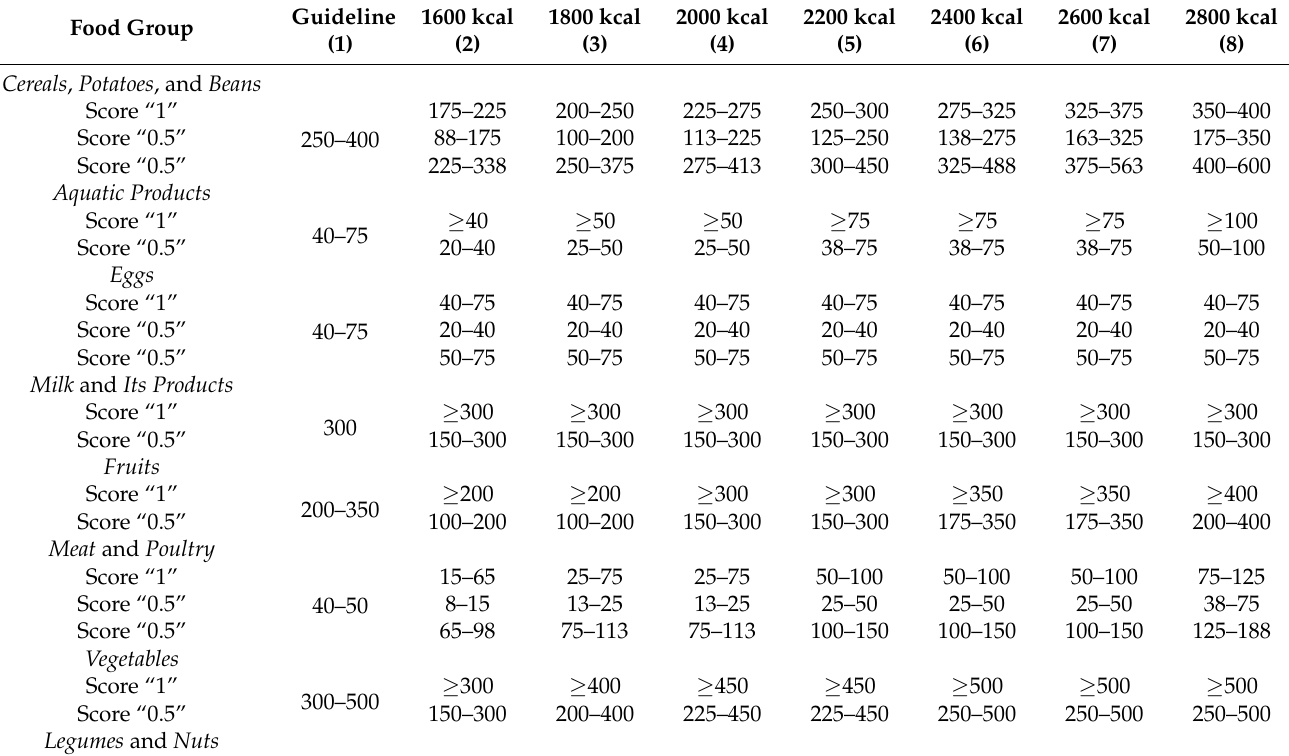
Table A1. Chinese Food Pagoda Score (CFPS) for various calorie